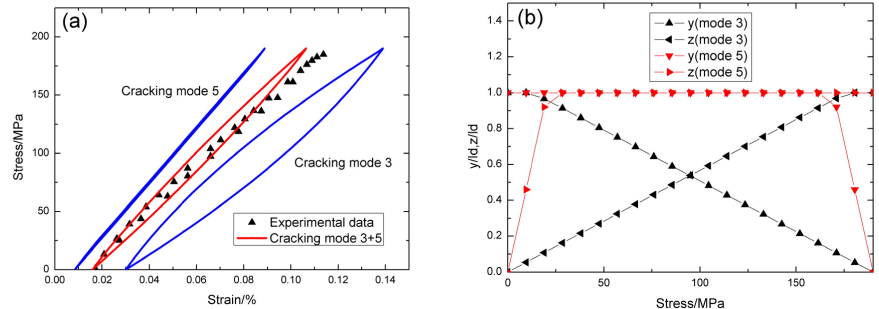
Figure 7. ( a ) The theoretical and experimental hysteresis loops; and ( b ) the interface slip lengths, i.e. , y / l d and z / l d , of matrix cracking mode 3 and mode 5 of cross-ply SiC/SiC composite when σ max = 190 MPa.